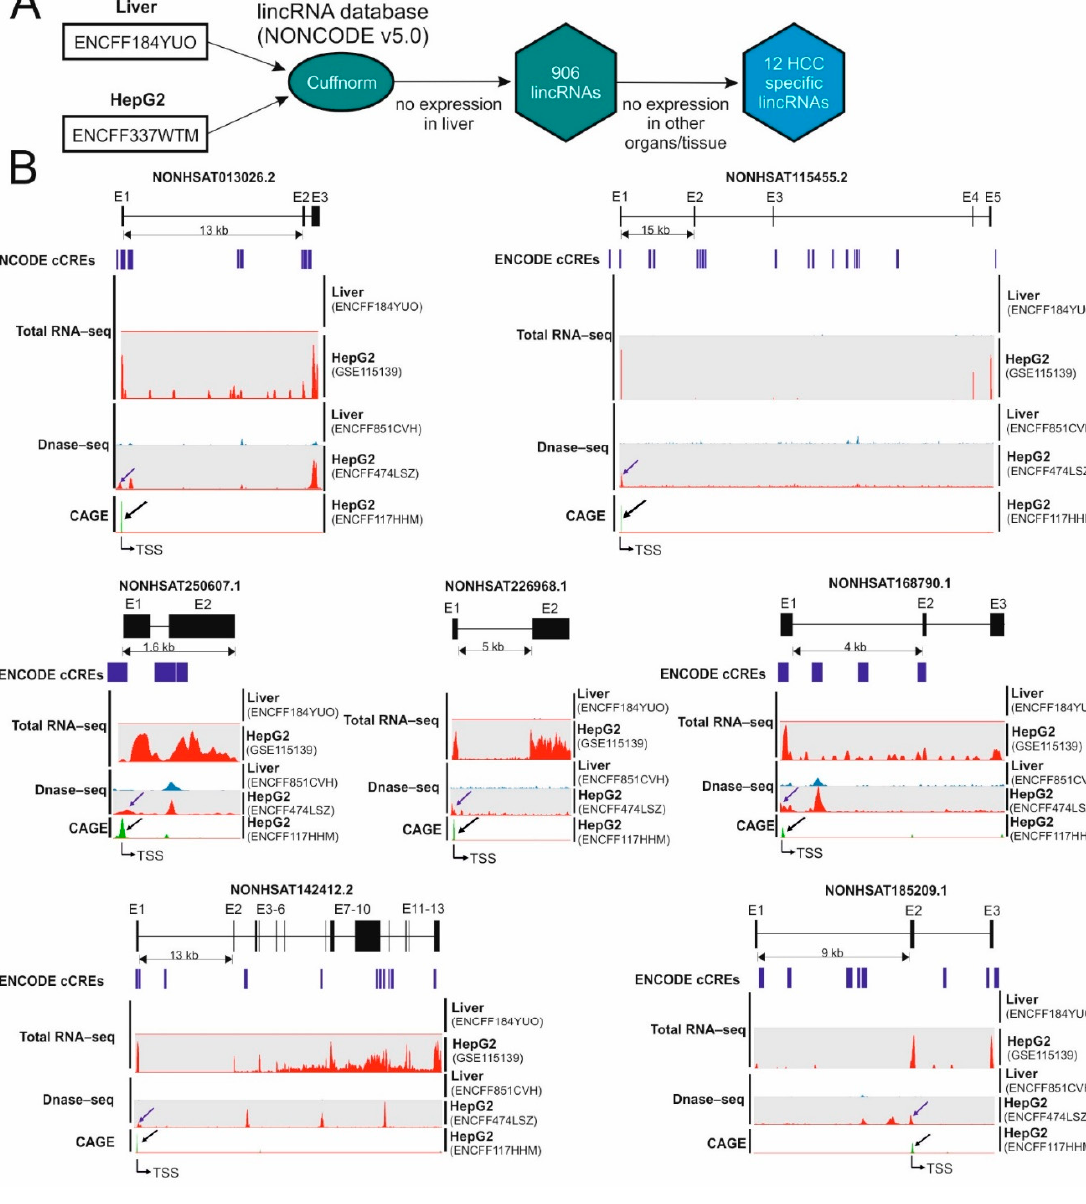
Figure 1. Identification of hepatocellular carcinoma-specific lncRNAs. ( A ) RNA-sequencing (RNA-seq) data from normal liver (ENCFF184YUO) and from the HCC cell line HepG2 (ENCFF337WTM) were aligned to the human reference genome (GRCh38) using Bowtie2. The gene expression values (Frag- ments per Kilobase Million (FPKM)) were calculated by Cuffnorm using the human NONCODE v5.0 transcript reference. A total of 906 long intergenic noncoding RNAs (lincRNAs) that were expressed in HepG2 cells but not in the normal liver were selected. Among these 906 lincRNAs twelve lincRNAs were